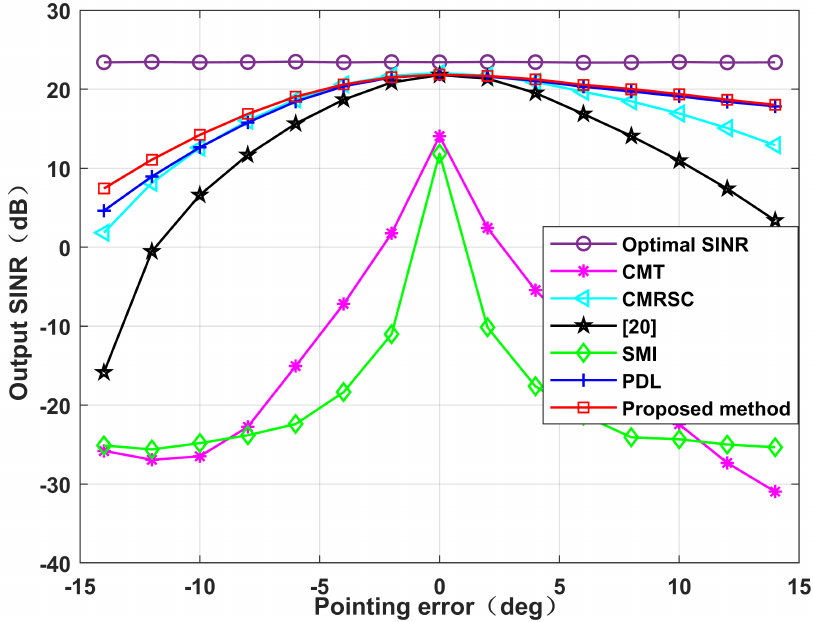
Figure 15. Output SINR at different mismatch angles. Simulation